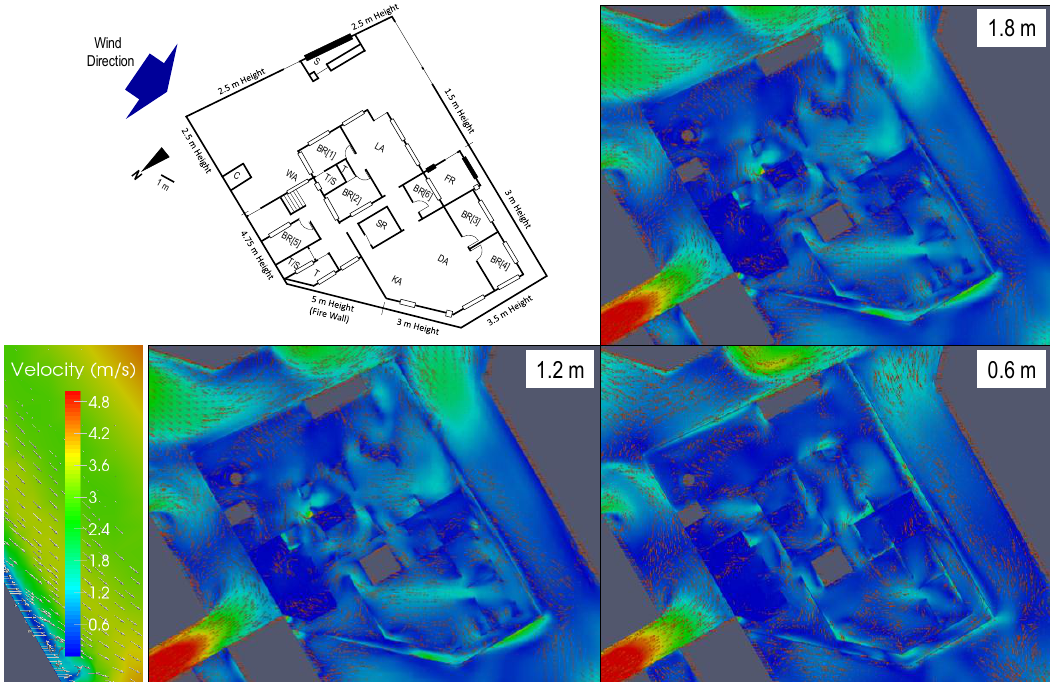
Figure 9 . Case 4—High lot perimeter wall and firewall (all windows and all internal doors opened) wind velocity around and inside the detached family house for three vertical heights (1.8 m, 1.2 m, and 0.6 m above the floor).